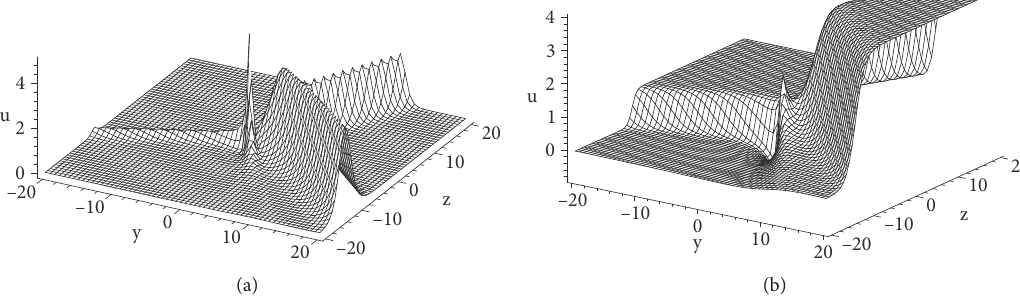
Figure 4: (a) 3-dimensional plot of the interaction solution between a lump and three solitons of (27) with the time 𝑡 = 0 ; (b) 3-dimensional plot of the interaction solution between a lump and a three-kink soliton of (28) with the time 𝑡 = 0 .